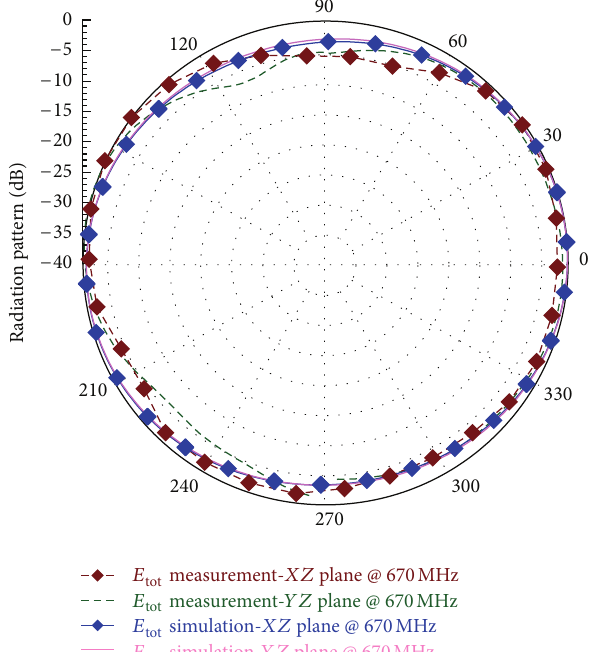
Figure 20: Simulated and measured radiation patterns (total E-field for the XZ and YZ planes) for the proposed dual-band L-shape PIFA at 670 MHz (central frequency for the DVB-T band).